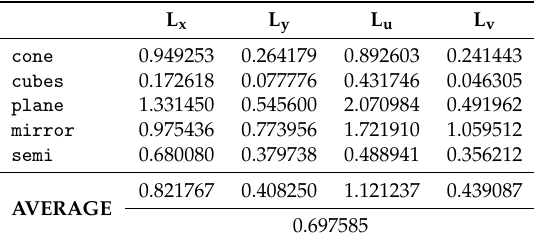
Table 9. Mean absolute differences of parallel input design with respect to reference implementation using floating-point. Pixel values range from 0 to